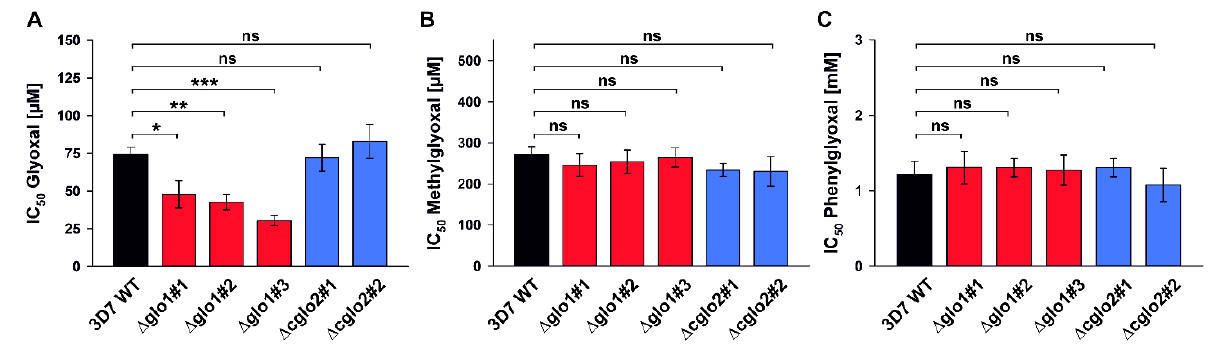
FIGURE 4: Growth inhibitory effects of exogenous 2-oxoaldehydes on synchronous ring-stage cell cultures of P. falciparum 3D7 wild-type strain and clonal 3D7Δglo1 and 3D7Δcglo2 knockout strains. IC 50 values were determined in 96-well plates using a SYBR green 1 assay for bolus treatments with (A) glyoxal, (B) methylglyoxal and (C) phenylglyoxal after 72 h incubation. The dose response curves are shown in Fig. S2. All data points are the mean ± S.D. from technical triplicate measurements of three to seven independent experiments. Statistical analyses were performed in SigmaPlot 12.5 using the one way ANOVA method (ns, not significant; * p < 0.05; ** p < 0.01; *** p <